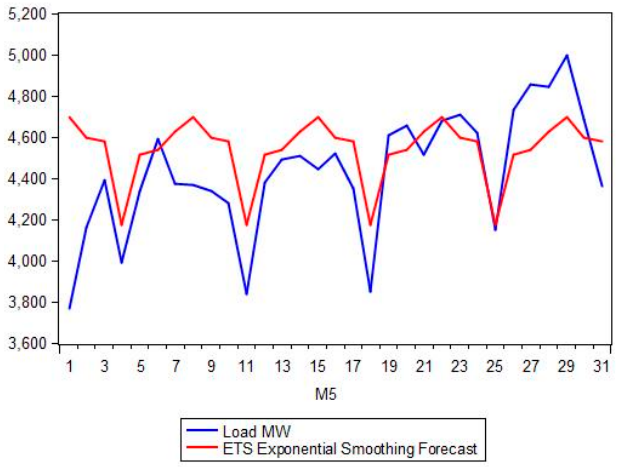
Figure 19. Exponential smoothing forecast for May 2014. Energies 2016 , 9 , 635